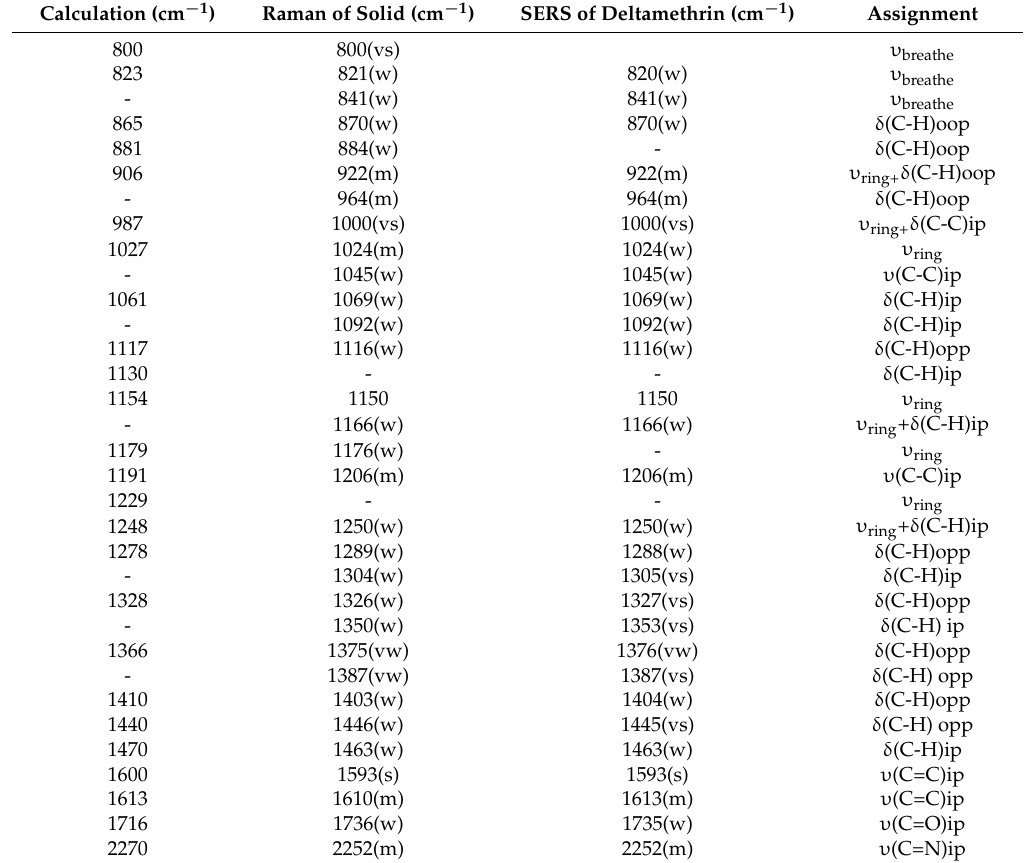
Figure 3 is the Raman shift deviation between the measured Raman characteristic peaks of deltamethrin and the Raman characteristic peaks calculated by DFT, where Raman shift deviation one (RSD1) is the deviation between Raman characteristic peaks of solid deltamethrin and Raman characteristic peaks calculated by DFT, and Raman shift deviation two (RSD2) is the deviation between the Raman characteristic peaks of the SERS of deltamethrin solution and Raman characteristic peaks calculated by